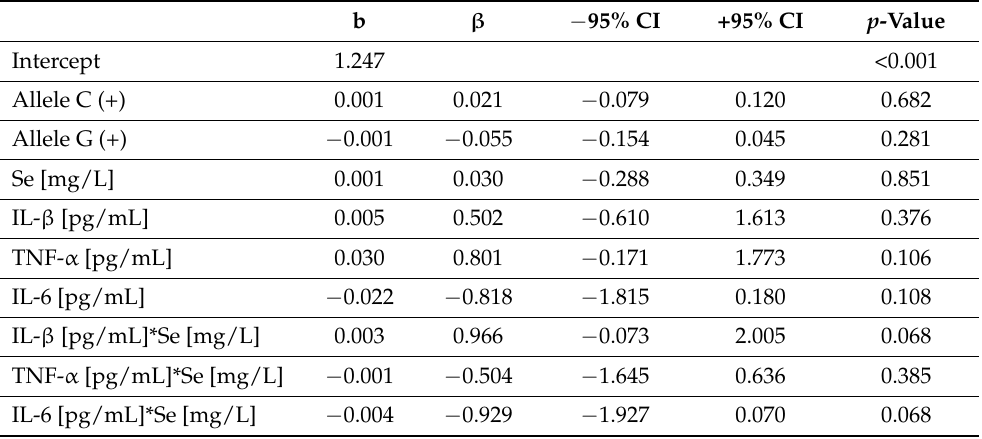
Table 11. Model I with moderation by selenium.